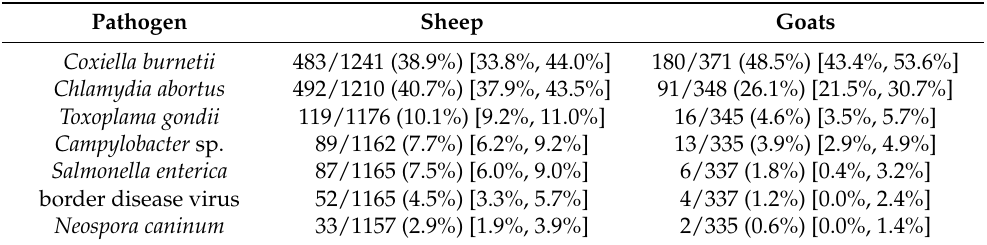
Table 2. Pathogens identified by qPCR and RT-qPCR in the ovine and caprine abortion samples studied from January to February 2022. Data are positive count/n, (%), 95% confidence interval limits [LL: low limit, UL: upper